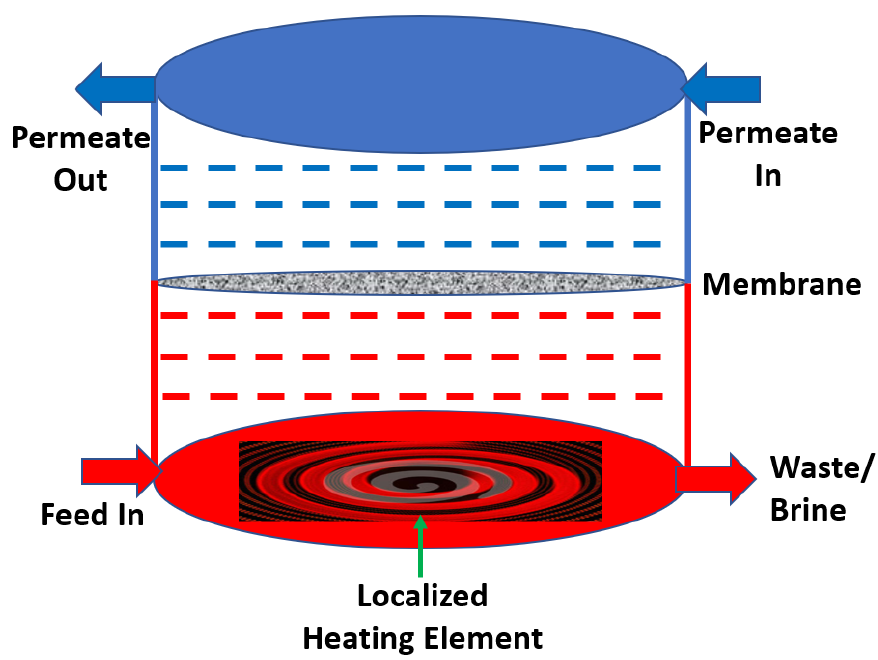
Figure 8. Schematic representation of DE ‐ MD Module.